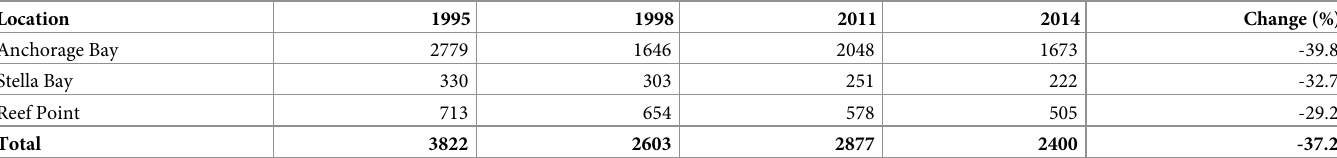
Table 4. Censuses of active nests of erect-crested penguins in late October at three locations on Antipodes Island over two decades (1995–2014).